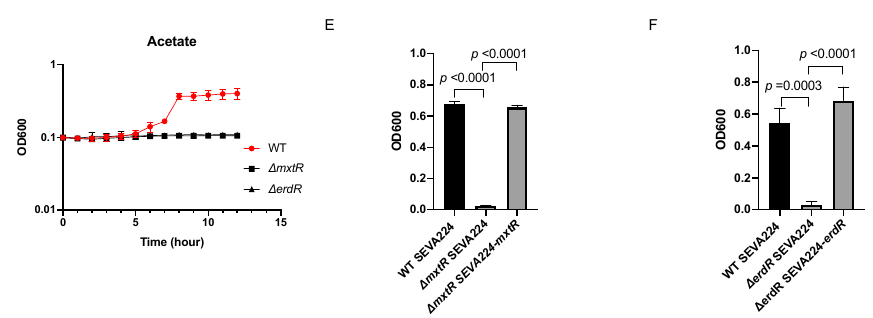
Figure 1. Growth phenotype of WT and the Δ mxtR and Δ erdR strains in the presence of different carbon sources. Growth experiments were performed in minimal medium supplemented with 20 mM glucose ( A ), 20 mM succinate ( B ), 0.2% v / v ethanol ( C ) or 20 mM acetate ( D – F ). For ( A – D ), overnight cultures of given strains were used to inoculate 100 µL of minimal medium in a 96-well plate with an initial OD 600 of 0.1. The plates were incubated at 30 °C with continuous shaking and the OD 600 was measured in a ClarioStar reader every 30 min. For ( E , F ), overnight cultures of the strains transformed with given plasmids were used to inoculate minimal medium with acetate plus 1 mM IPTG with an initial OD 600 of 0.1. The cultures were incubated at 30 °C and after 20 h, the OD 600 was measured. All the experiments were performed a minimum of three times.